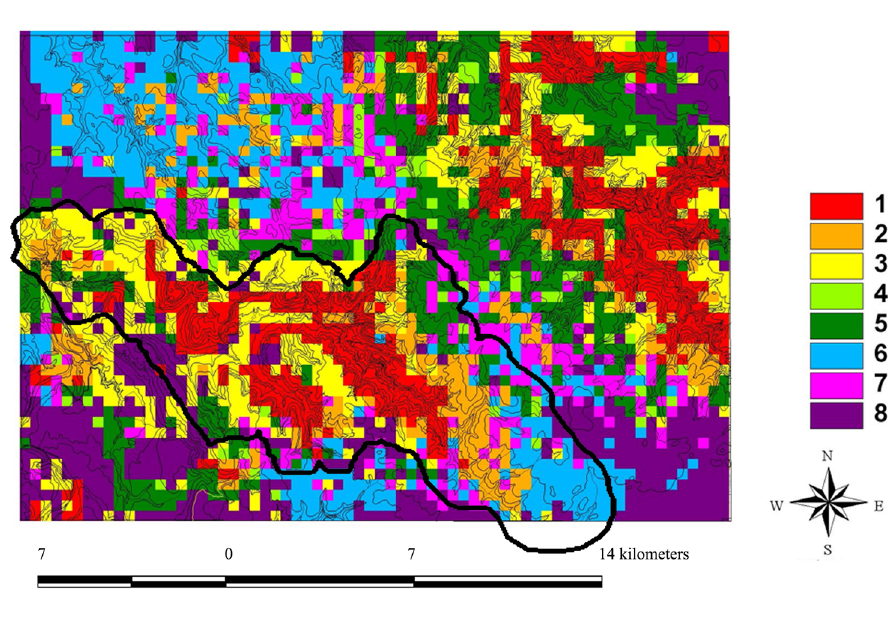
Figure 6: Multiscale cartographic model of the most probable soil-vegetation NS-classes based on nutrient-sensitive properties. Classes 1…8 – see in text. Bold black curve – boundary of the Zayachya river basin Main features of soil-vegetation NS-classes: 1 – dominance of alder, aspen, and megatrophic herb species or cultivated areas on humus-rich weakly alkaline soils. 2 – high abundance of mesotrophic and megatrophic herb and shrub species on nutrient-rich weakly acid soils. 3 – dominance of pine, Vaccinium vitis-idaea , and boreal herbs on nutrient-poor strongly acid soils. 4 – elevated abundance of spruce, pine, boreal mesophytes, and hygrophytes on nutrient-poor weakly acid soils. 5 – high abundance of pine, boreal mesophytes and hygrophytes on weakly acid soils with medium nutrients supply. 6 – dominance of spruce, pine, and typical boreal species on nutrient-poor acid soils. 7 – elevated abundance of aspen, Vaccinium myrtillus , and boreal herbs on weakly acid soils with medium nutrients supply. 8 – high abundance of pine and boreal species or hygrophytes on strongly acid nutrient-poor